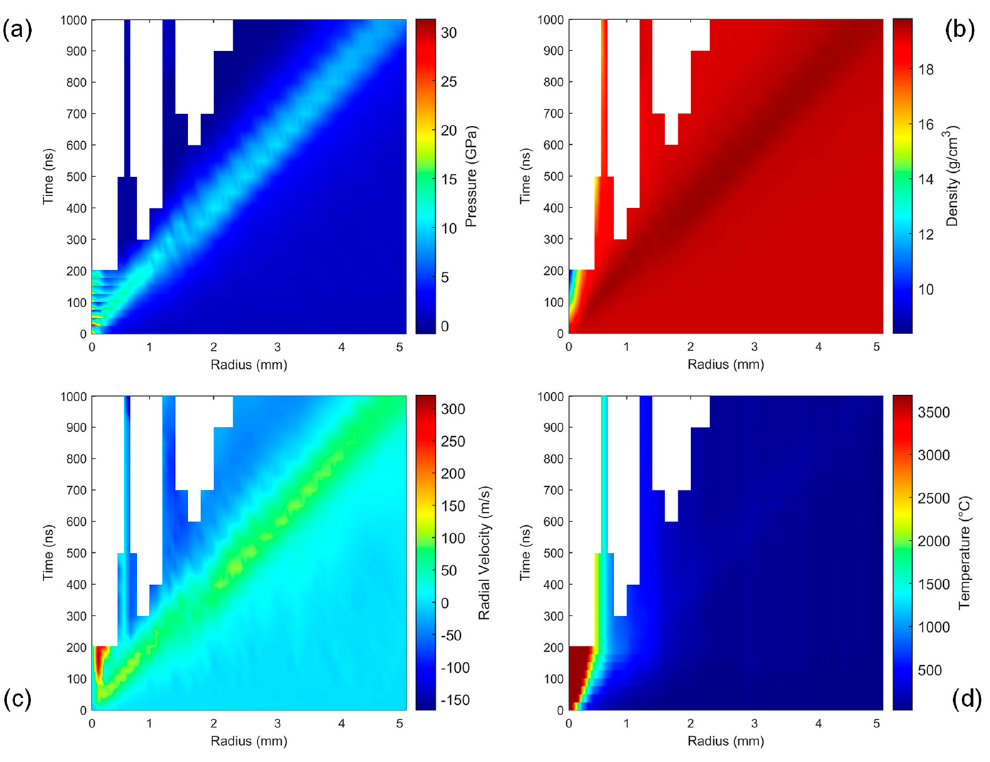
Figure 9. Pressure ( a ), density ( b ), particle velocity in radial direction ( c ), and temperature ( d ) distributions by varying the radius at the impacted base (L 0 of Figure 5).